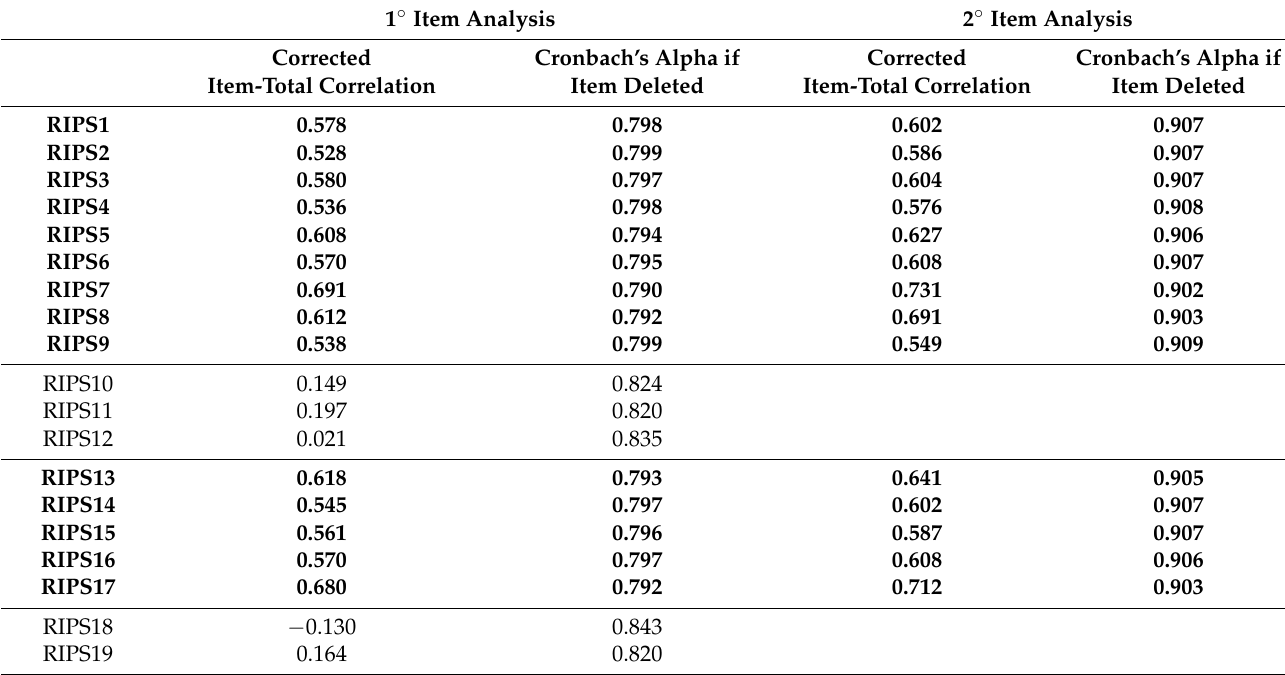
Table 4. Corrected item-total correlation and alpha if items deleted